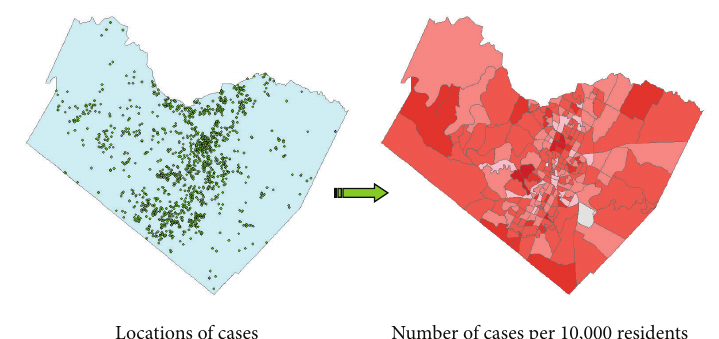
Figure 3: Spatial aggregation of individual cases using census enumeration units. Individual geocoded locations (left) are aggregated using census tracts (right). The count of the number of cases per census tract is used to determine relevant population-weighted indices, such as the number of cases per 10,000 residents. Determining incidence or disease rates, as opposed to raw counts, is one of the primary reasons for aggregation. As a secondary benefit, spatial aggregation greatly reduced the reidentification risk.